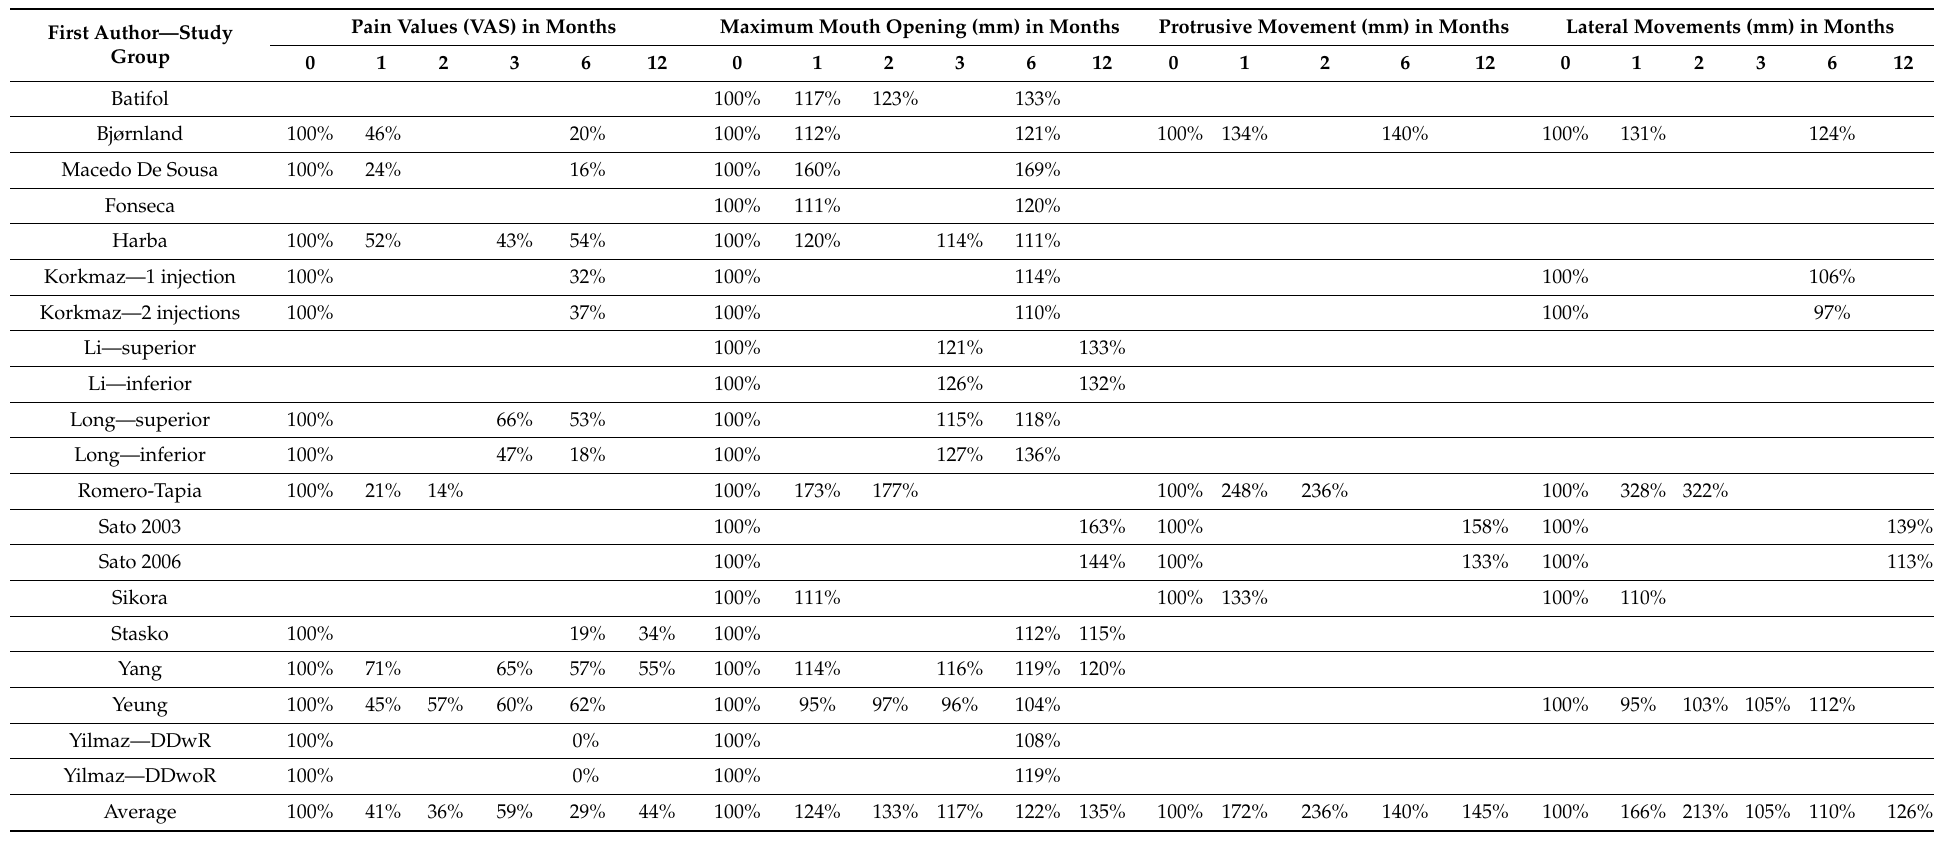
Table 7. The effectiveness of HA therapies conducted by various